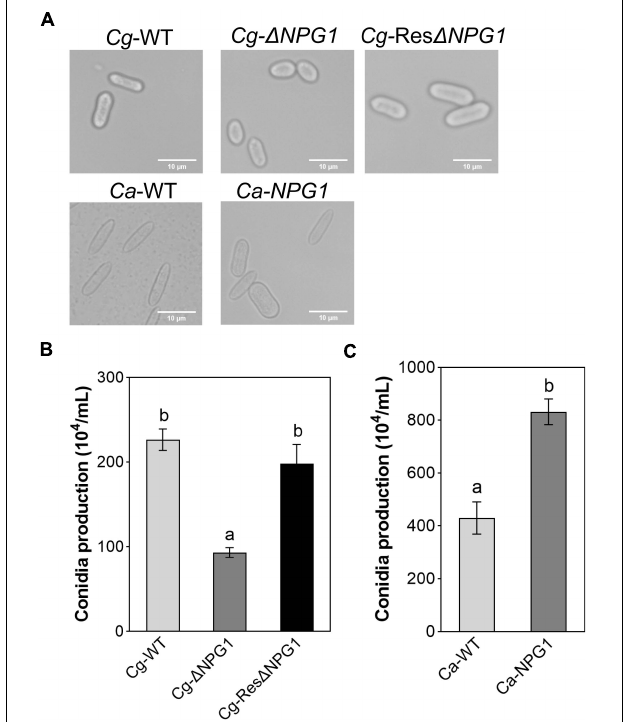
FIGURE 5 | Conidia morphology observation and conidiation assay of CgNPG1 deletion mutant, CgNPG1 complementation mutant, and CgNPG1 heterologous expression mutant. (A) Conidial morphology of Cg-WT, Cg- (cid:49) NPG , Cg-Res (cid:49) NPG1, Ca-WT, and Ca- NPG1. (B) The number of conidia developed by the Cg-WT, Cg- (cid:49) NPG , Cg-Res (cid:49) NPG1 . (C) The number of conidia developed by the Ca-WT and Ca- NPG1 . Error bars indicated standard deviation, and columns with different letters indicate significant difference ( P <